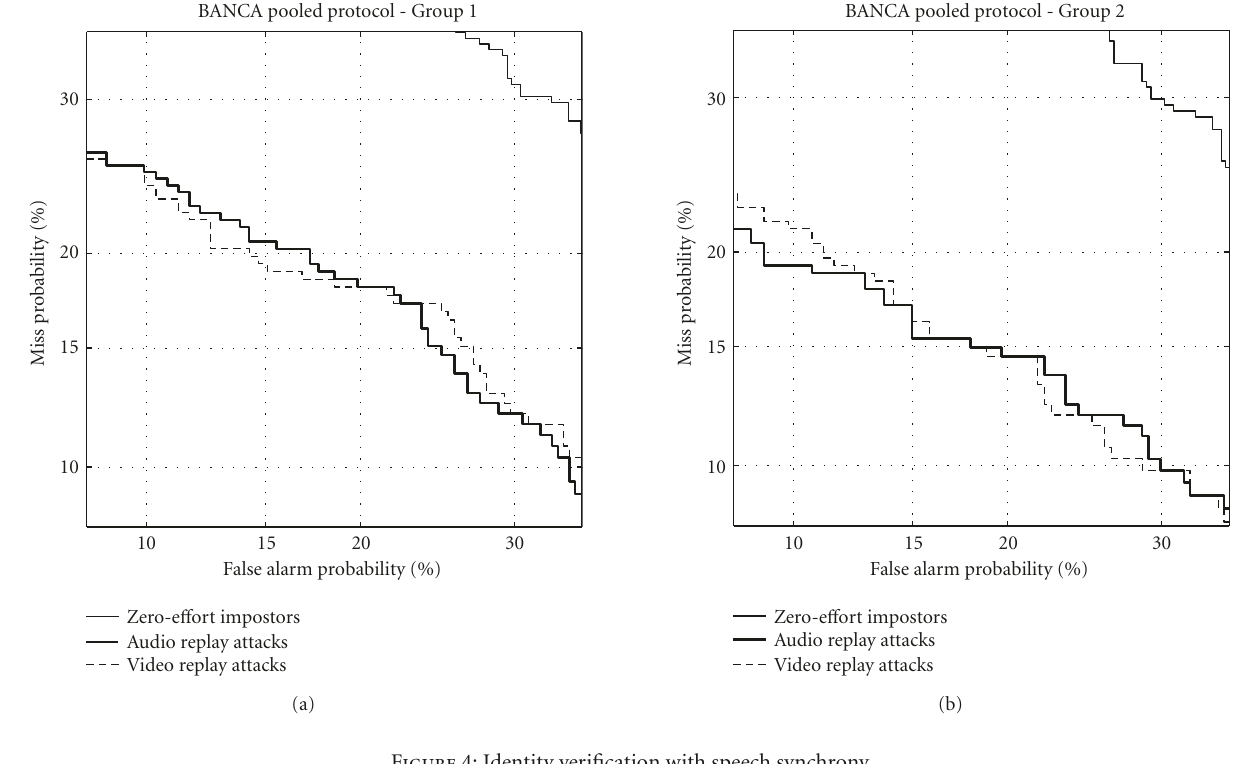
Figure 4: Identity verification with speech